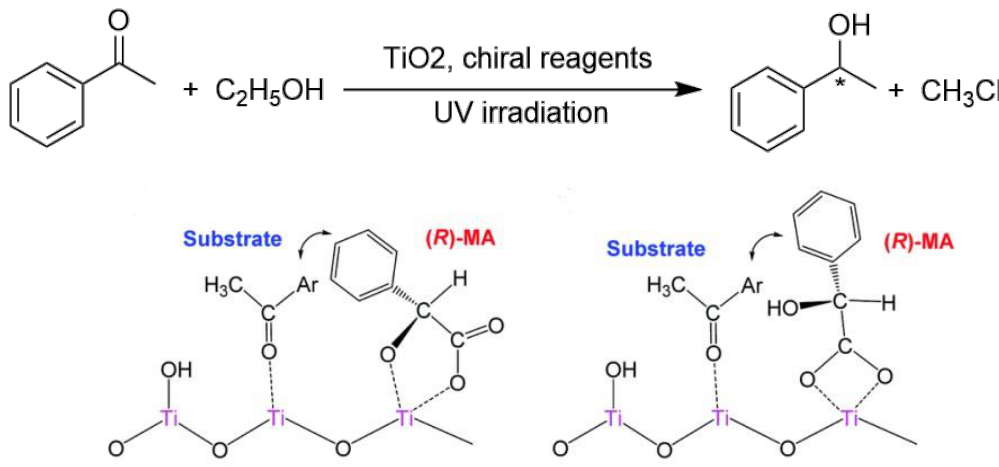
asymmetric aliphatic aldehyde α - alkylation using α -bromomalonate as alkylating reagent